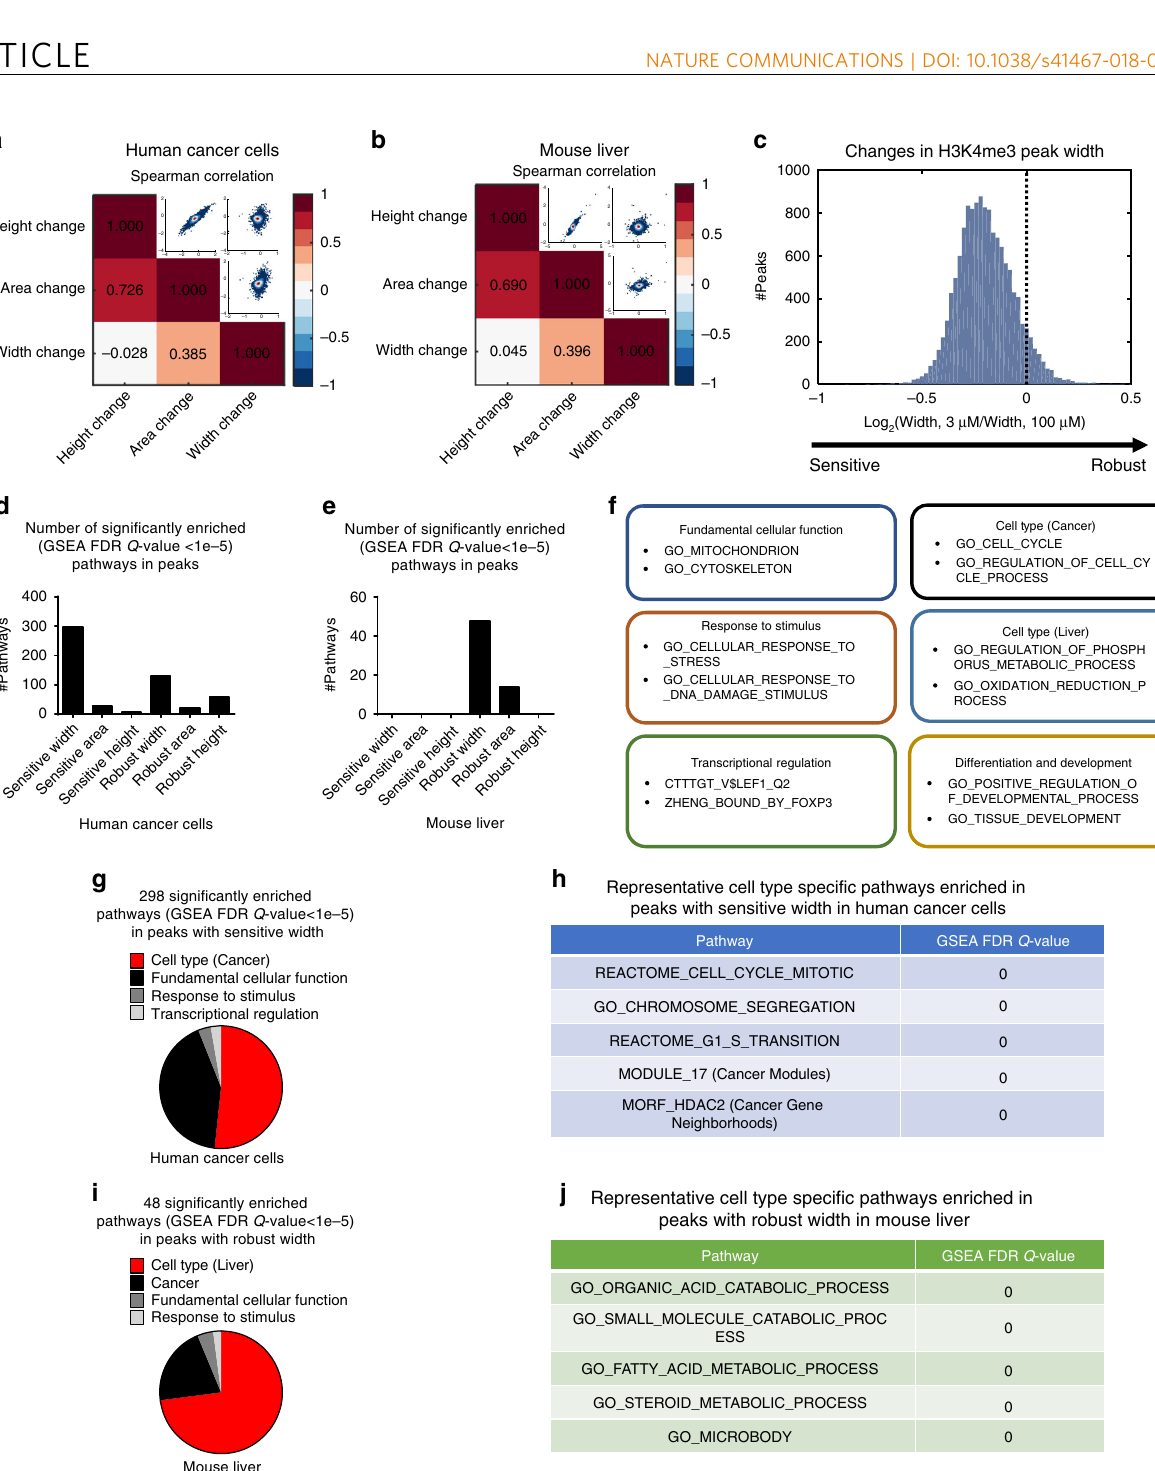
Fig. 2 H3K4me3 width dynamics encode biological information. a Heat map showing Spearman ’ s rank correlation coef fi cients among fold changes of H3K4me3 peak heights, areas, and widths under MR in human cancer cells. The upper right part shows density scatter plots comparing the corresponding log2(fold change) values. Colors of dots in the scatter plots indicate density of dots. b Same as in a but for mouse liver. c Distribution of fold changes (de fi ned by the values in low methionine condition divided by the corresponding values in high methionine condition) in peak width. The arrow at the bottom denotes the change from sensitive (more reduction in peak width) to robust (less reduction in peak width). d Number of pathways signi fi cantly enriched (GSEA FDR Q -value< 1e-5) in peaks with different dynamics under MR in human cancer cells. e Same as in d but for mouse liver. f Examples of annotated pathways in each category. g Annotation of 298 MSigDB pathways enriched in H3K4me3 peaks with sensitive width in human cancer cells. h Representative cancer-related pathways enriched in H3K4me3 peaks with sensitive width in human cancer cells. i Annotation of 48 MSigDB pathways enriched in H3K4me3 peaks with robust width in mouse liver. j Representative liver-speci fi c pathways enriched in H3K4me3 peaks with robust width in mouse